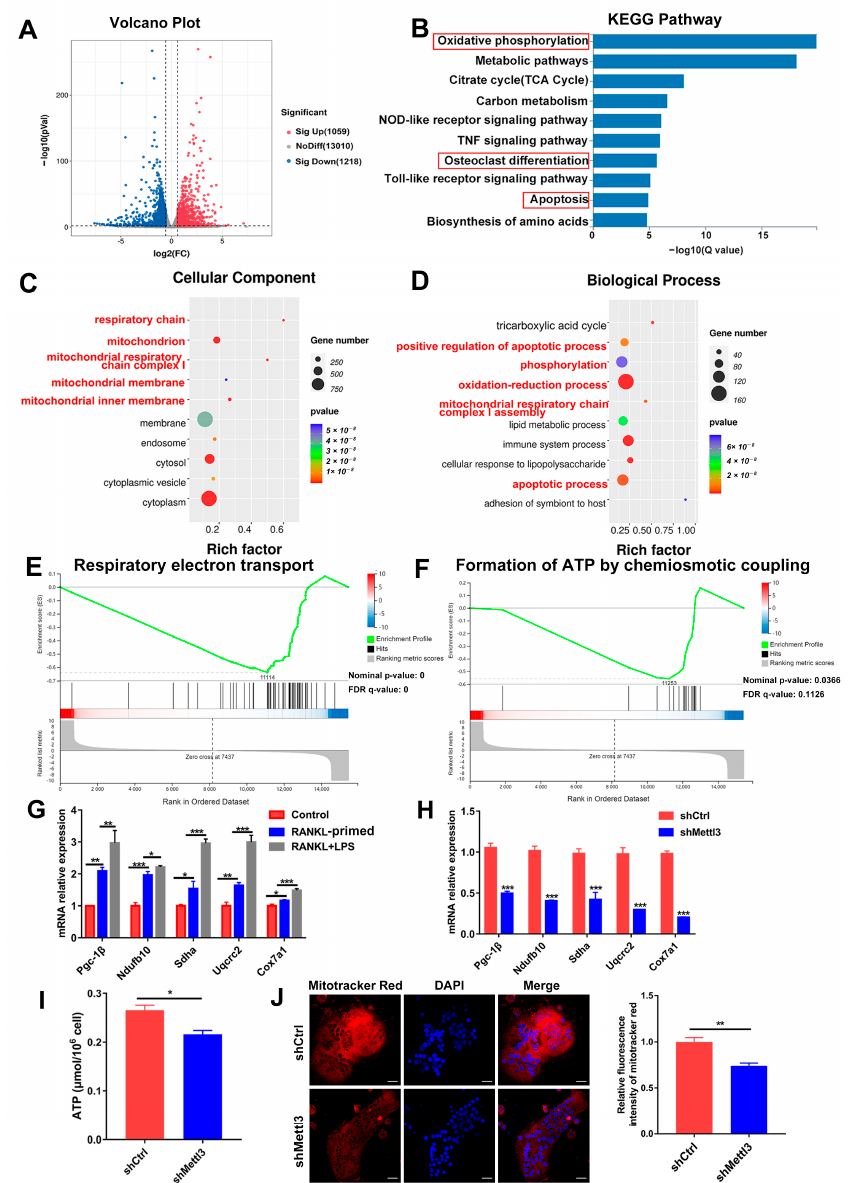
Figure 3. Effect of METTL3 deficiency on mitochondrial homeostasis during LPS-induced osteoclastogenesis. ( A ) The volcano plot exhibited differentially expressed genes (DEGs) between the shMettl3 and shCtrl groups ( p < 0.01, fold change >1.5 or <0.67, compared to the shCtrl group). ( B ) Enriched KEGG pathways of DEGs. ( C , D ) GO analysis bubble charts of cellular components and biological processes showing the top ten enriched terms of DEGs. ( E , F ) The GSEA enrichment plots of mitochondrial function-related gene sets, including respiratory electron transport ( E ) and formation of ATP through chemiosmotic coupling ( F ). The nominal p -value and false discovery rate (FDR) are shown in plots. Significance threshold was set to p -value < 0.05, FDR < 0.25. ( G ) qRT-PCR was performed to detect the mRNA expression of Pgc-1 β , Ndufb10 , Sdha , Uqcrc2 and Cox7a1 during LPS-induced osteoclastogenesis. ( H – J ) Osteoclast precursors transfected with the Mettl3 shRNA or negative control shRNA were induced to differentiate into osteoclasts. ( H ) Pgc-1 β , Ndufb10 , Sdha , Uqcrc2 and Cox7a1 mRNA levels were measured using qRT-PCR. β -Actin was used as an internal normalized control. ( I ) ATP content was detected using an ATP assay kit. ( J ) Confocal images of osteoclasts stained with Mito-Tracker Red CMXRos and DAPI. Scale bars, 25 µ m. The relative fluorescence intensity of Mito-Tracker Red was analyzed with the ImageJ software. The results are shown as the mean ± SD ( n = 3). * p < 0.05; ** p < 0.01; *** p <